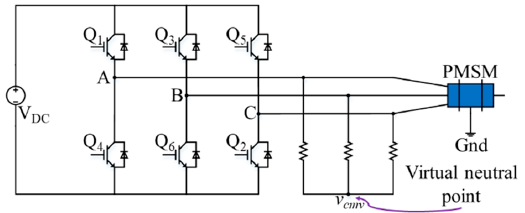
Figure 2. A common inverter topology used in most of the drives.